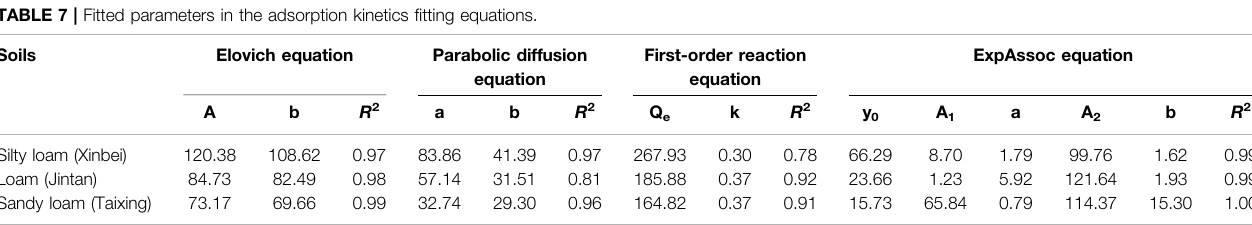
TABLE 7 | Fitted parameters in the adsorption kinetics fi tting equations. Soils Elovich equation Parabolic diffusion